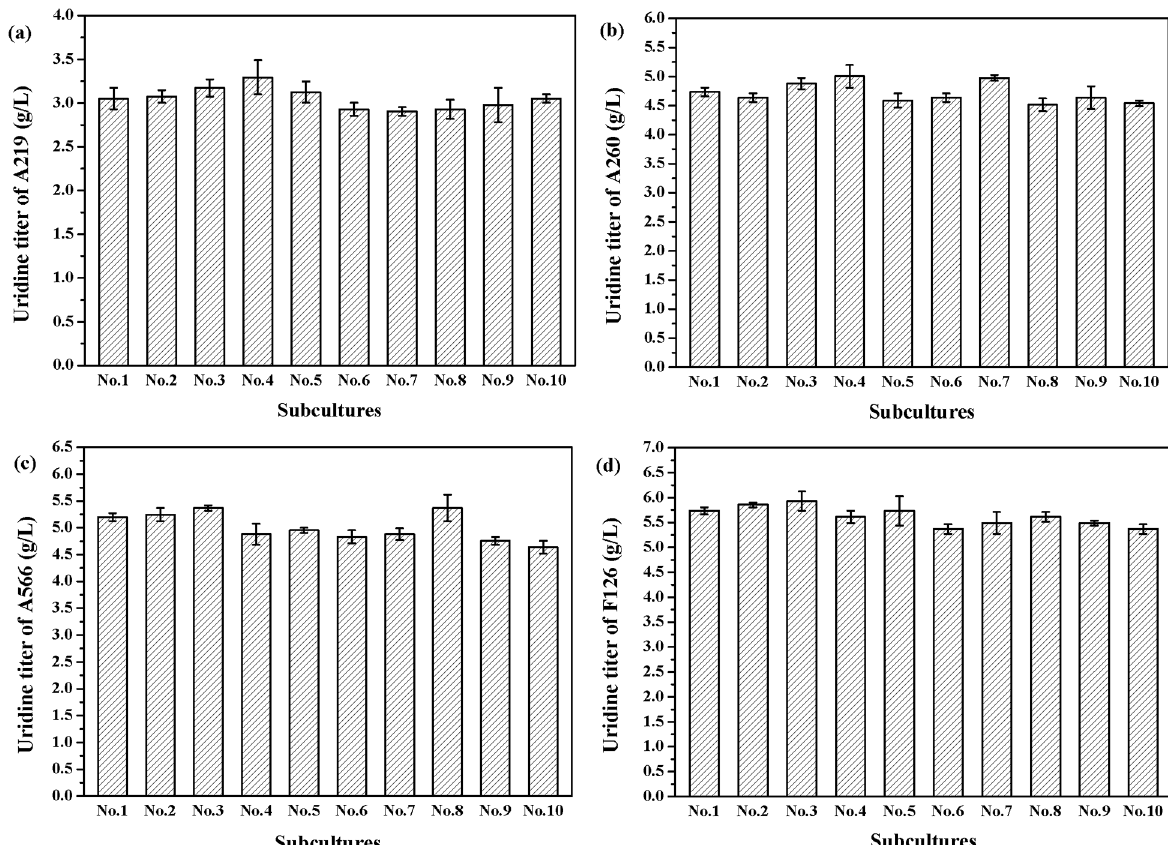
Fig 4. Stability test of mutant strains in ten batches sub-cultures. (a) Mutant A219; (b) Mutant A260; (c) Mutant A566; (d) Mutant F126.